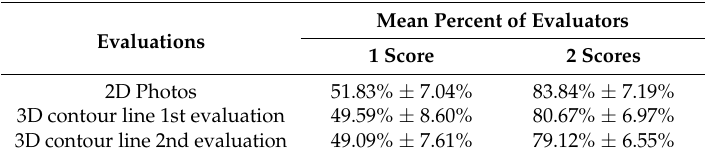
Table 2. Mean percent of the evaluators who rated the 80 2D photos and the 3D contour line images with the most common scale rating within a one to two scores